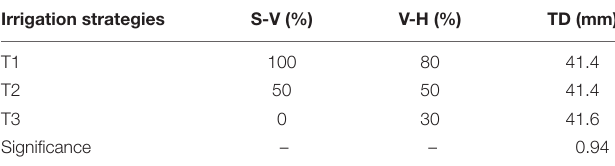
TABLE 1 | Water application as a percentage of actual evapotranspiration (ET a ). Irrigation